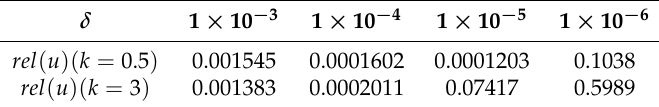
Table 2. The relative error rel ( u ) of Example